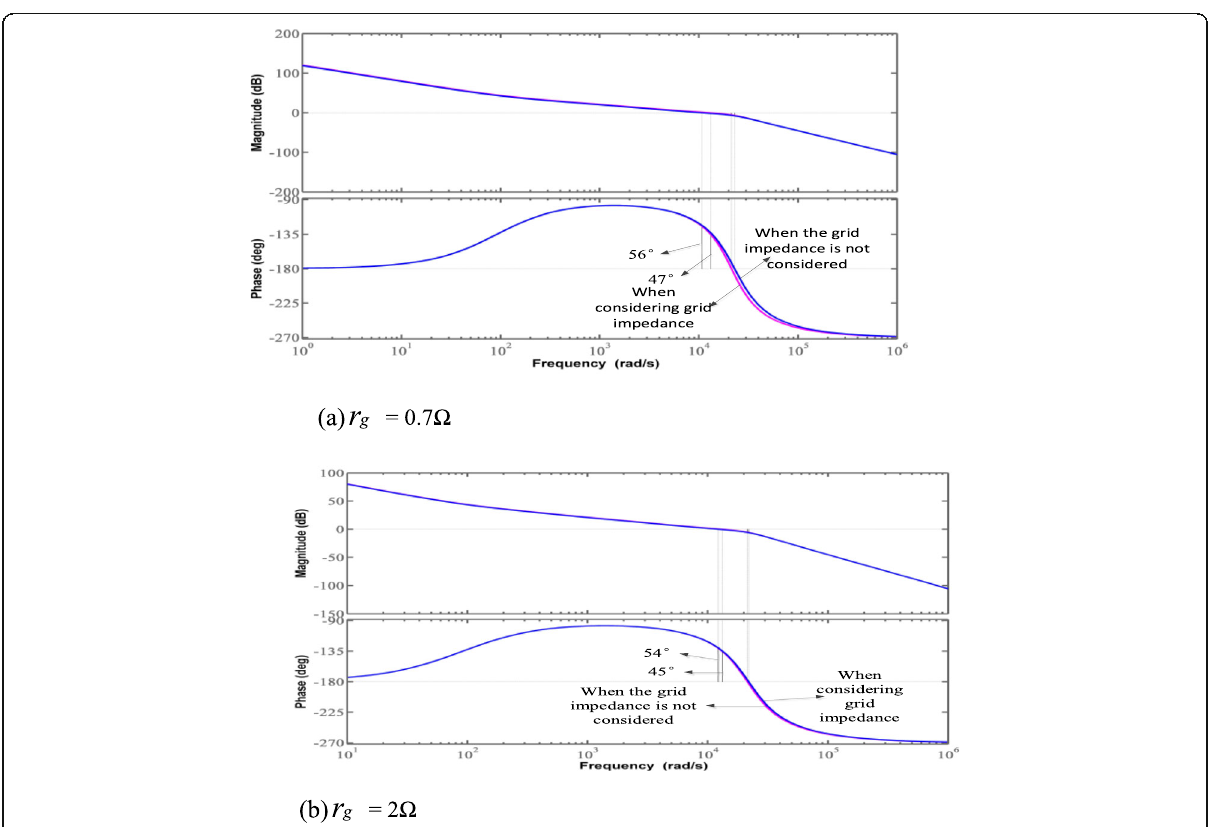
Fig. 3 Bode diagram of active damping control based on grid voltage feedforward under pure resistance. a rg = 0.7 Ω . b rg = 2